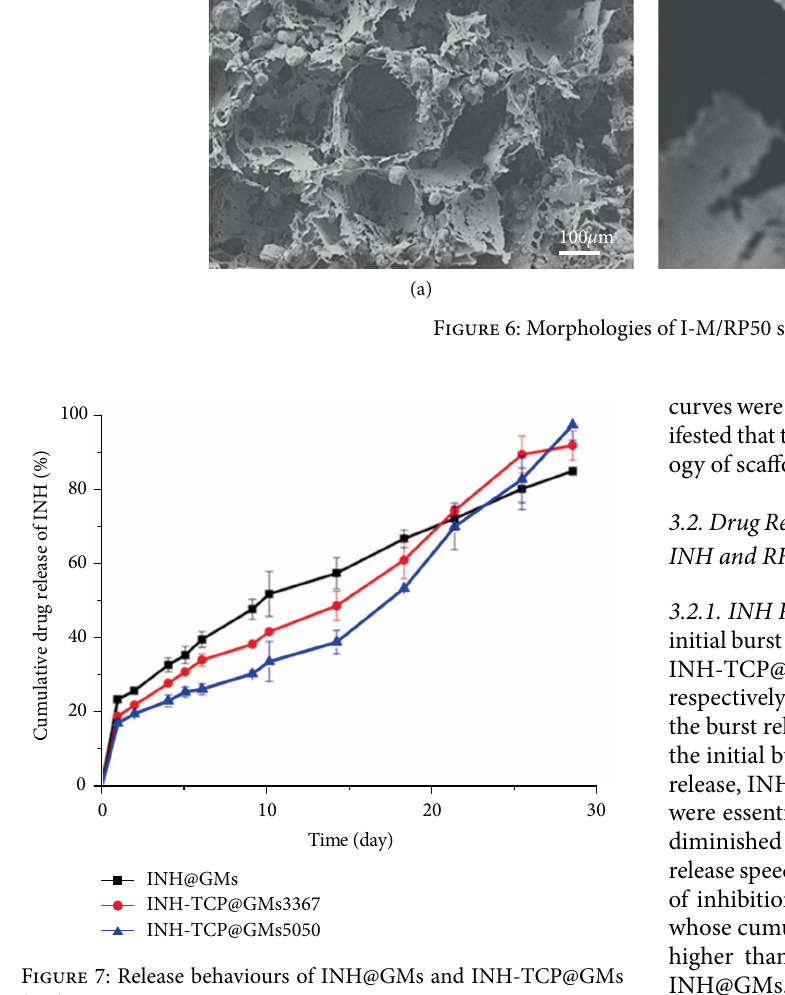
Figure 7: Release behaviours of INH@GMs and INH-TCP@GMs in vitro